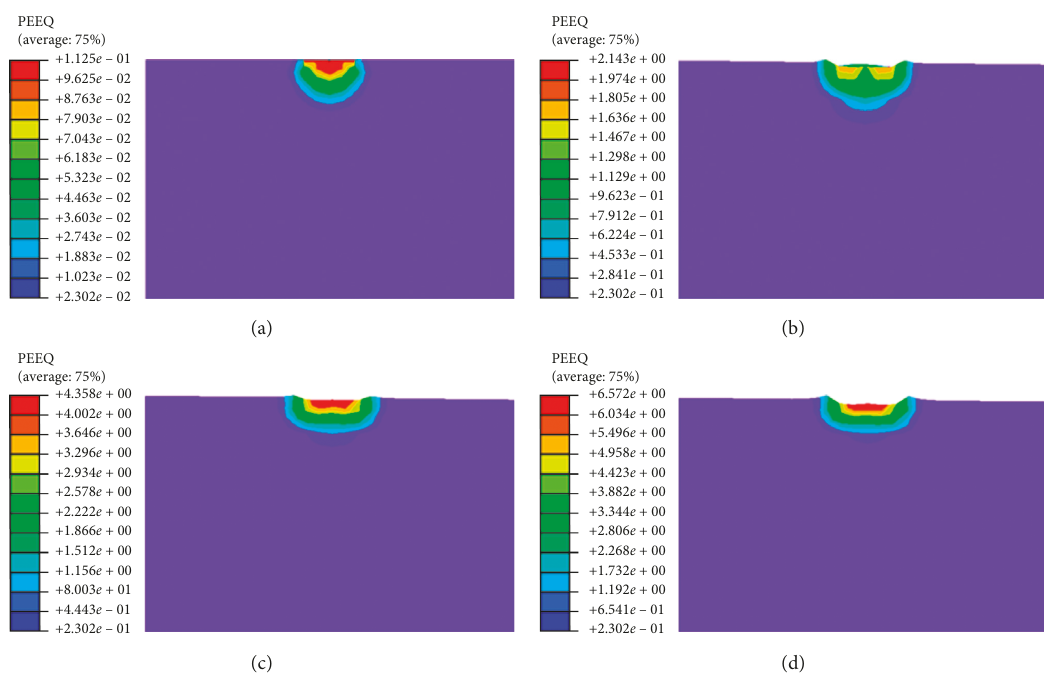
Figure 13: Equivalent plastic strain cloud. (a) First strike. (b) Third strikes. (c) Fifth strikes. (d) Seventh strikes.